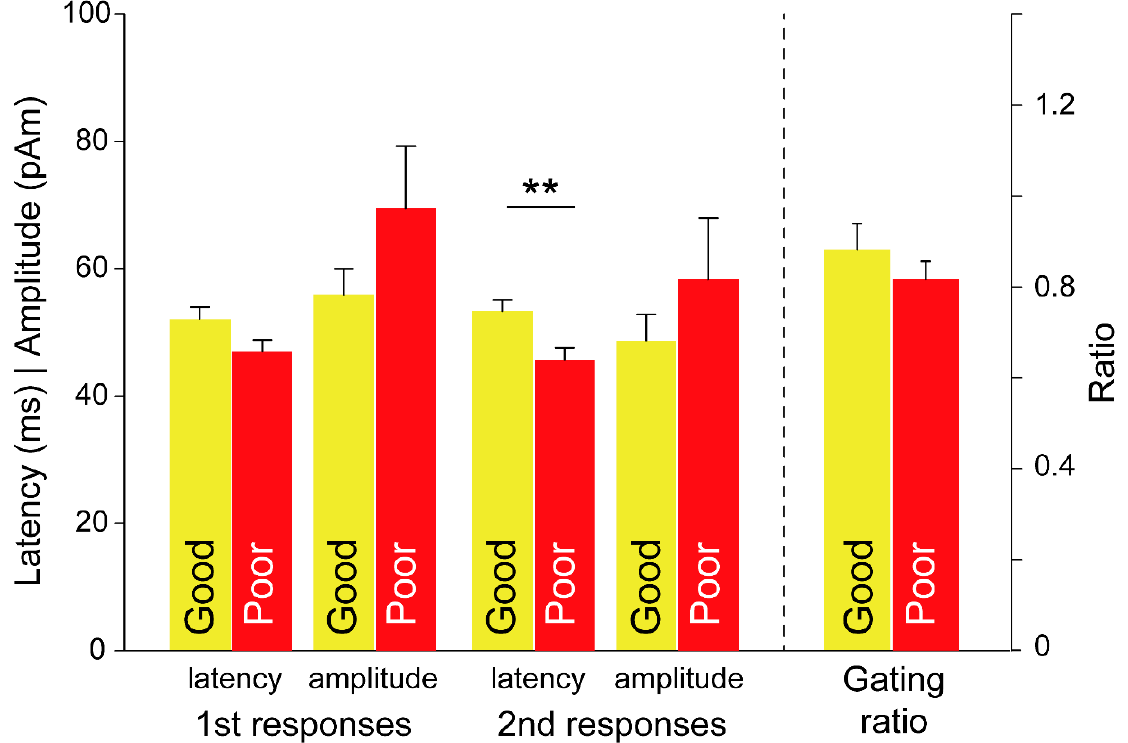
Figure 3. Differences in somatosensory amplitude and latency responses, and in gating ratio in patients with episodic migraine for the effect of treatment outcomes. **, p < 0.01.